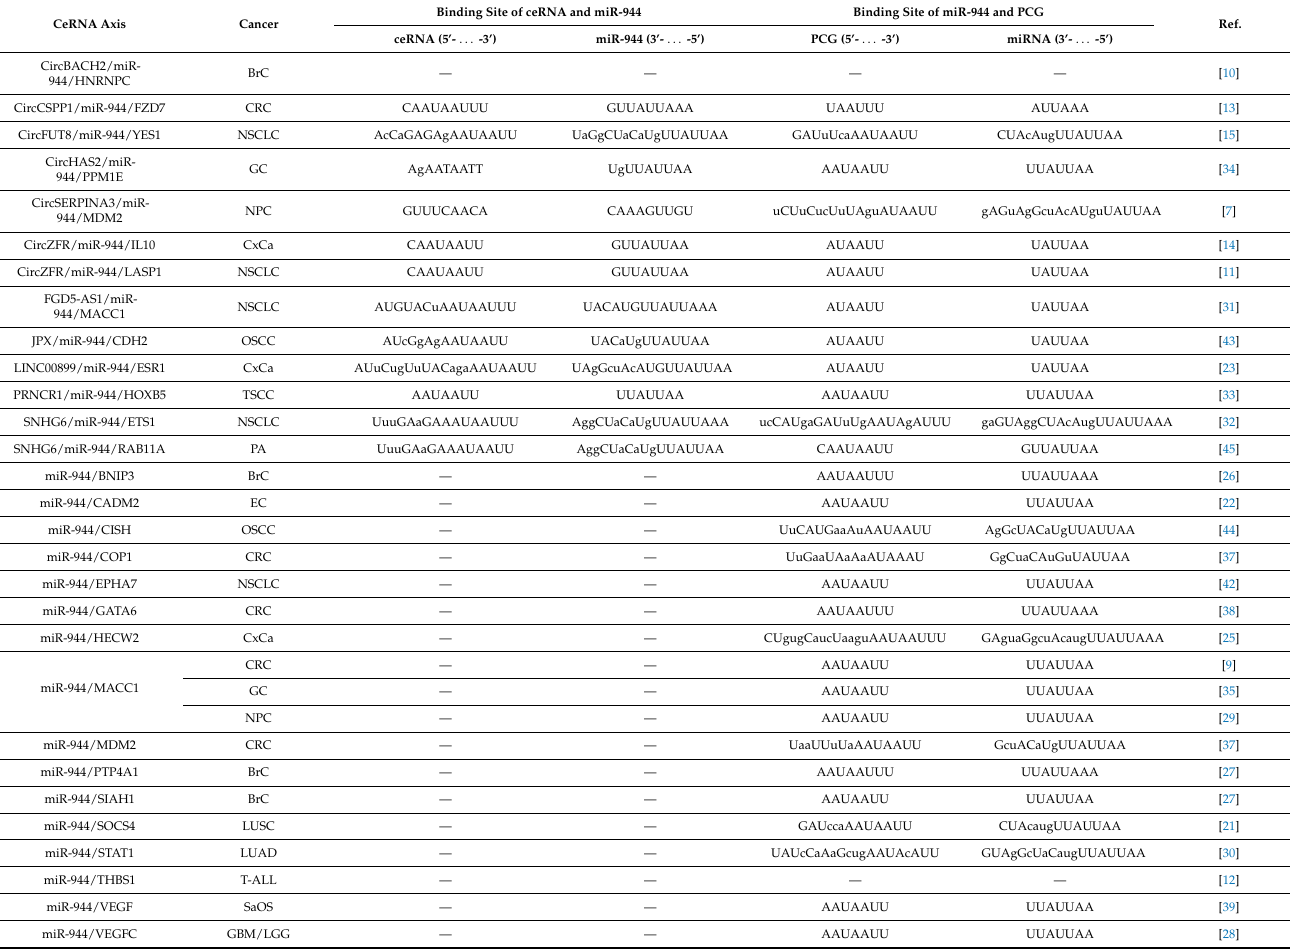
Table 4. The ceRNAs of miR-944.